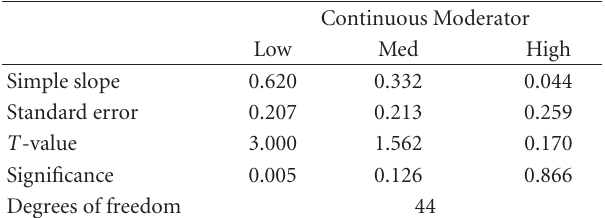
Table 8: Simple slope